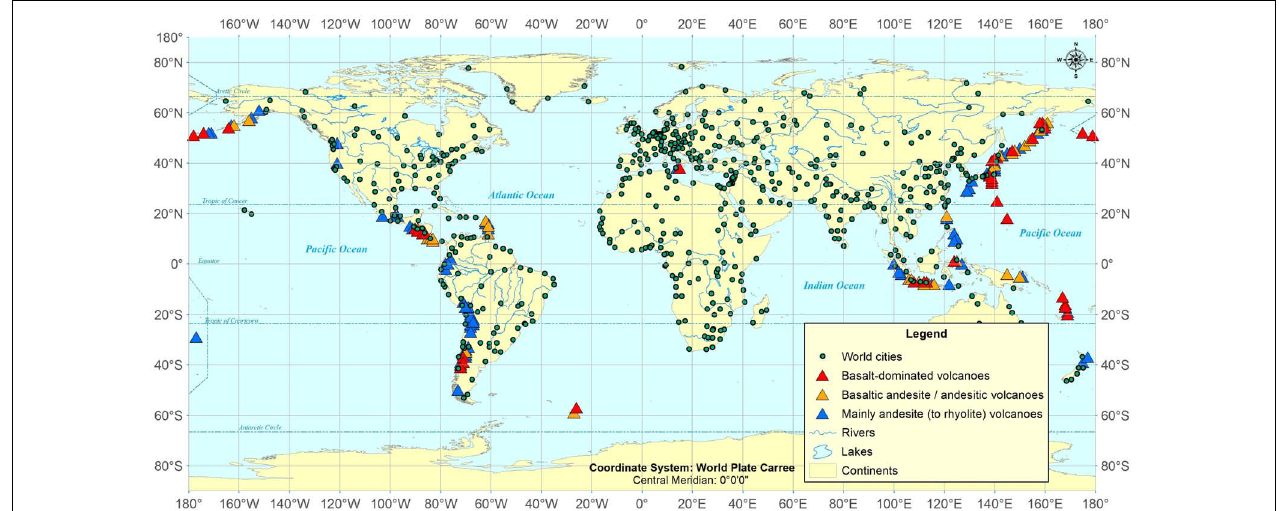
FIGURE 1 | Location map of mafic volcanoes in arc settings. Data source: Global Volcanism Program